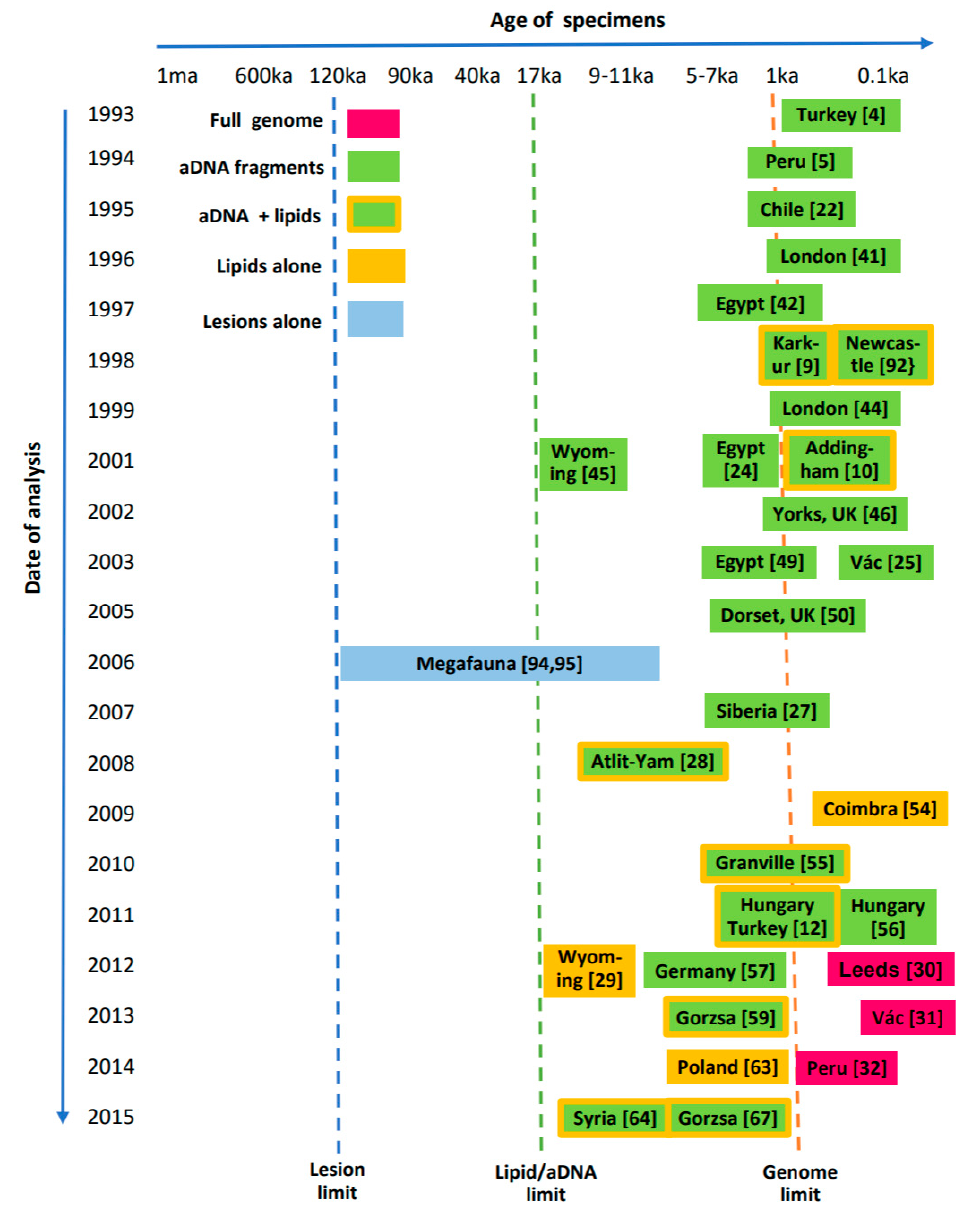
Figure 11. Interrelation between age of suspected ancient tuberculosis specimens and dates of various analytical investigations. Vertical dotted lines show current limits for diagnostic techniques.